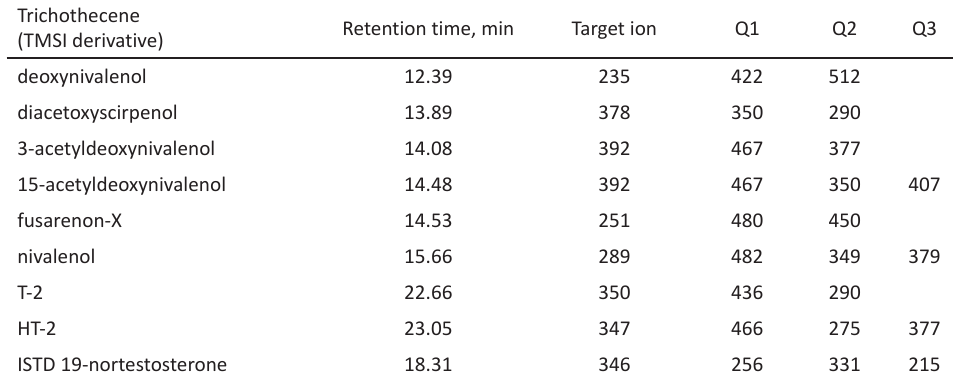
Table 1. Trichothecenes were quantified as their trimethylsilyl imidazole (TMSI) derivatives by GC-MS; retention times, target ions and qualifier ions (Q1, Q2, Q3) in the selective ion monitoring method (SIM) are given. 19-nortestosterone was used as internal standard